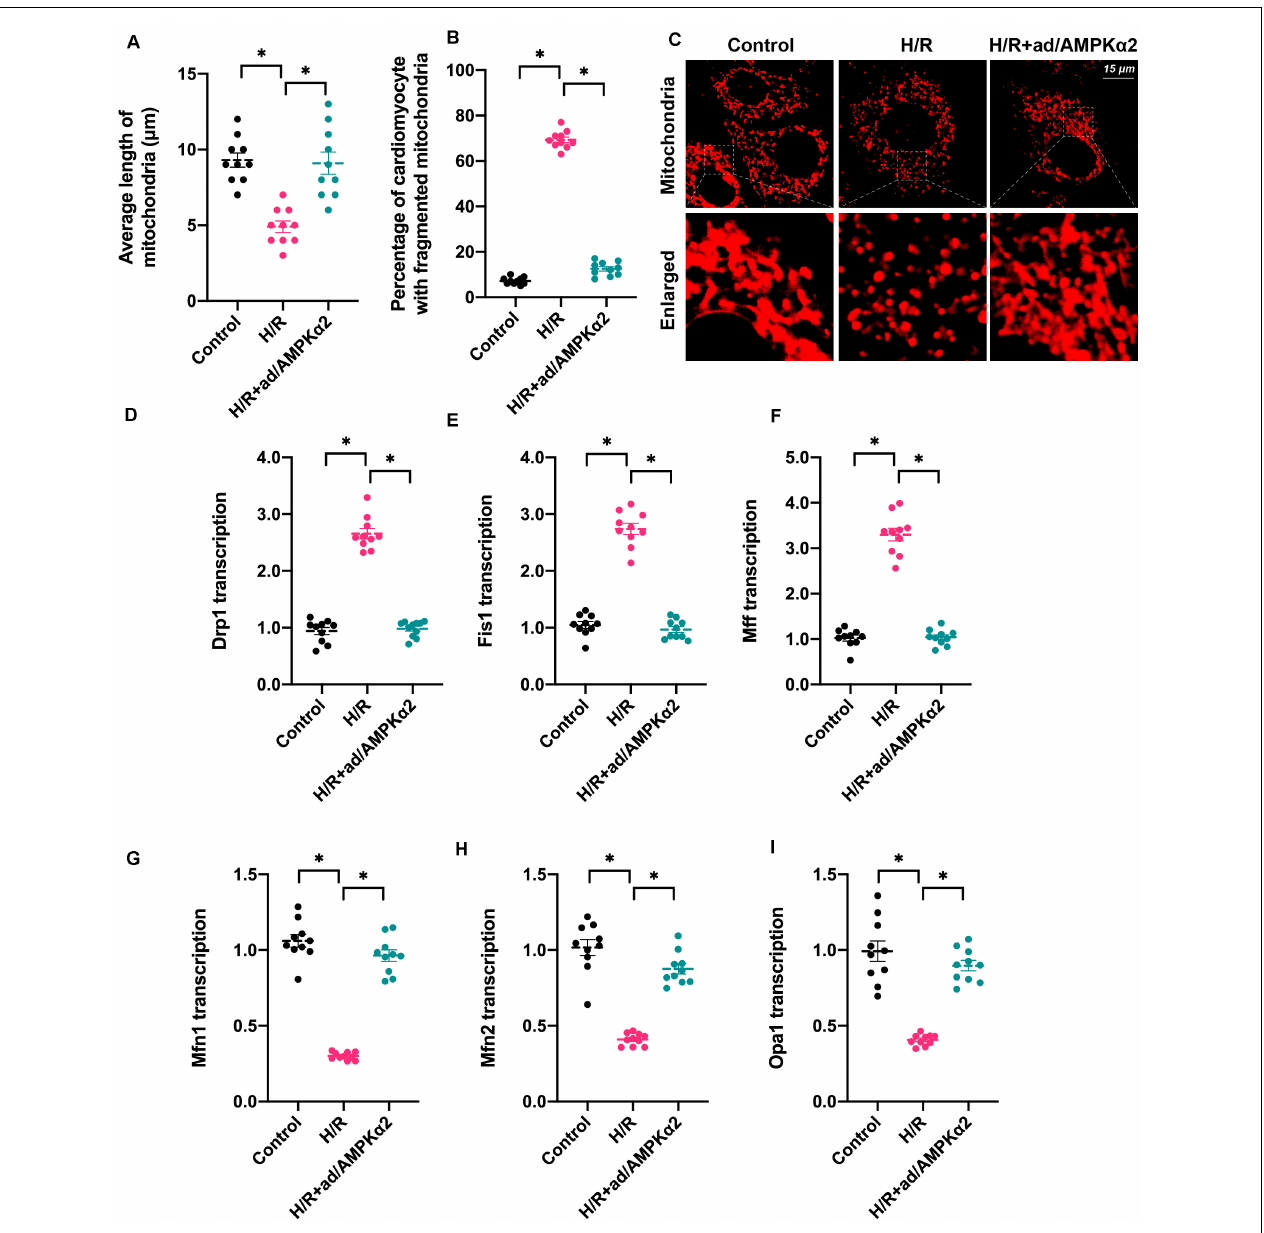
FIGURE 3 | Mitochondrial dynamics are disrupted by hypoxia/reoxygenation due to decreased AMPK2 α . (A–C) Mitochondrial morphology was measured through immunofluorescence. The average length of mitochondria as well as the ratio of cardiomyocyte with fragmented mitochondria was measured. (D–I) RNA was isolated from treated cardiomyocytes, and then the transcription of Drp1, Mff, Fis1, Mfn1, Mfn2, and Opa1 was measured. The data represent the mean ± SEM. P <